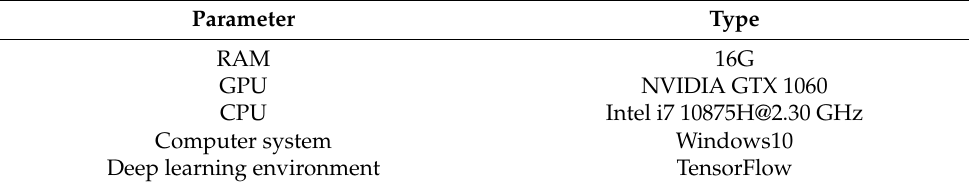
Table 3. Computer system configuration and simulation environment.